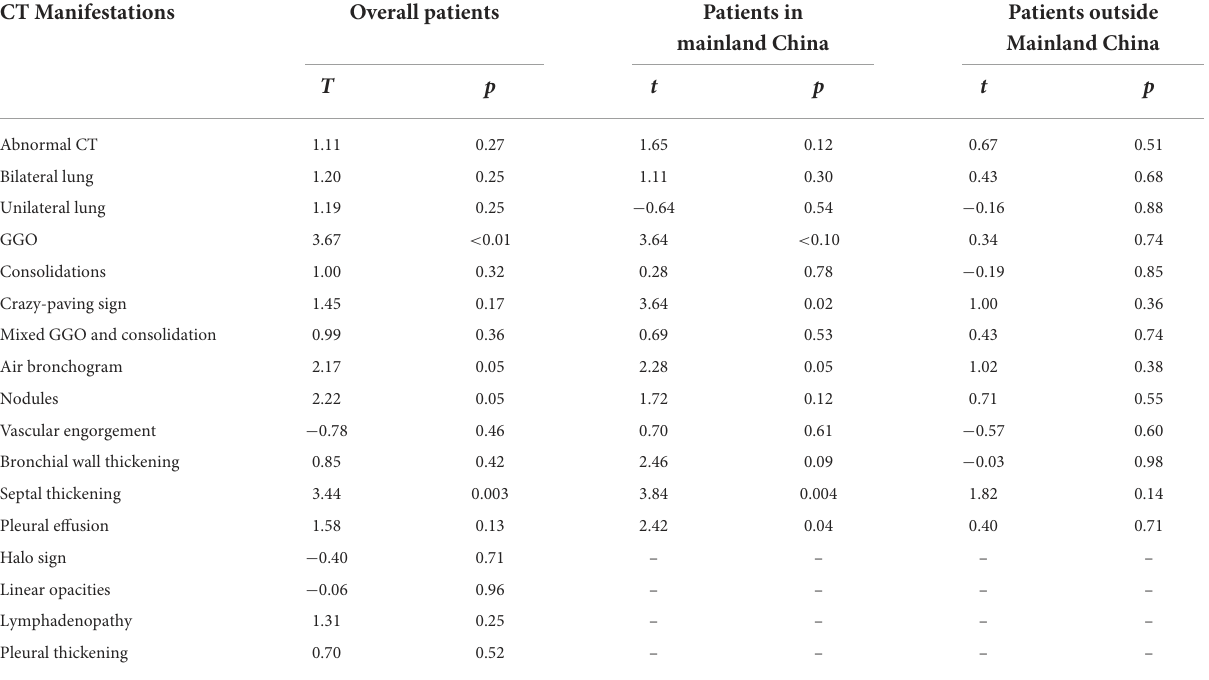
TABLE 2 Egger’s test